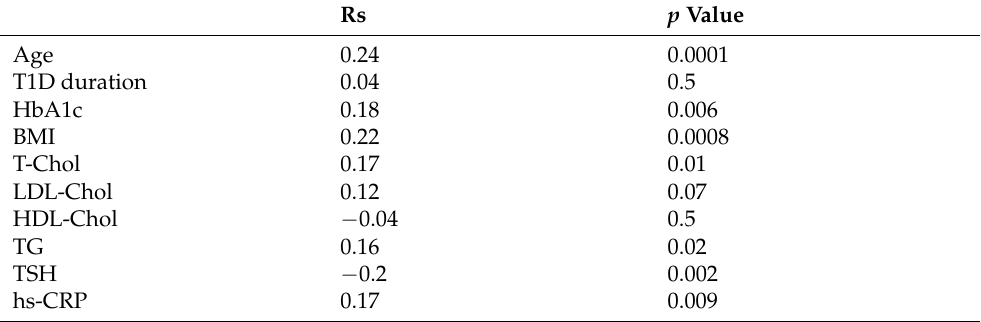
Table 3. Correlation between various parameters and API (Spearman’s rank correlation analysis).